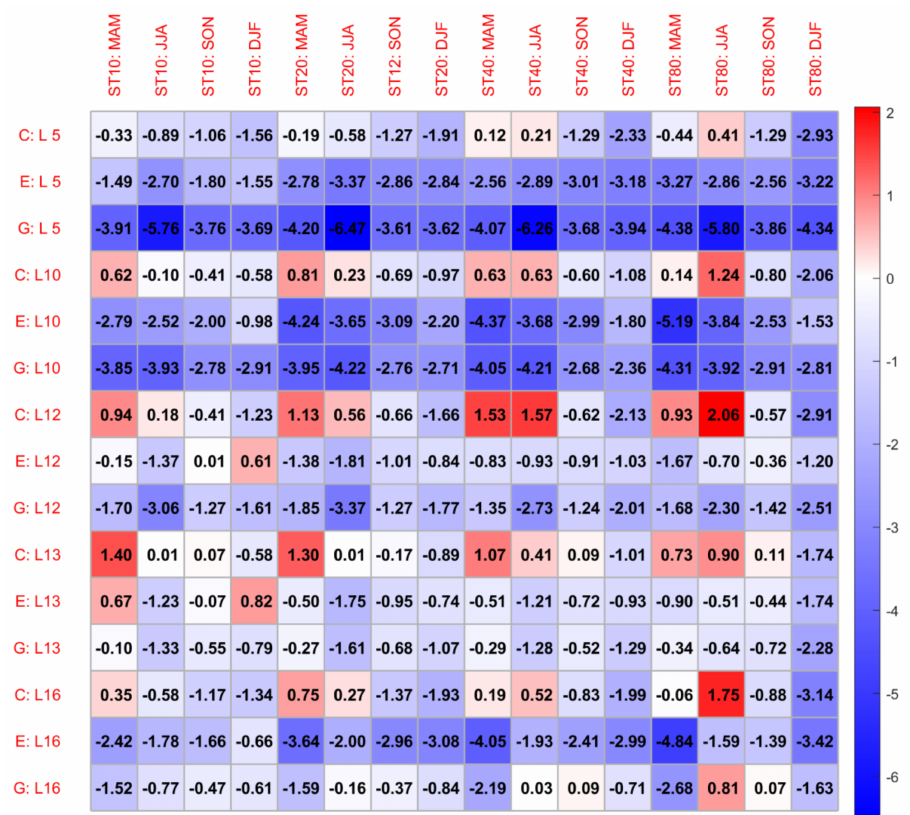
Figure 11. Seasonal variations in ME for different land-uses (category 5, 10, 12, 13, 16). Y label C is CLDAS, E is ERA-Interim, G is GLDAS.